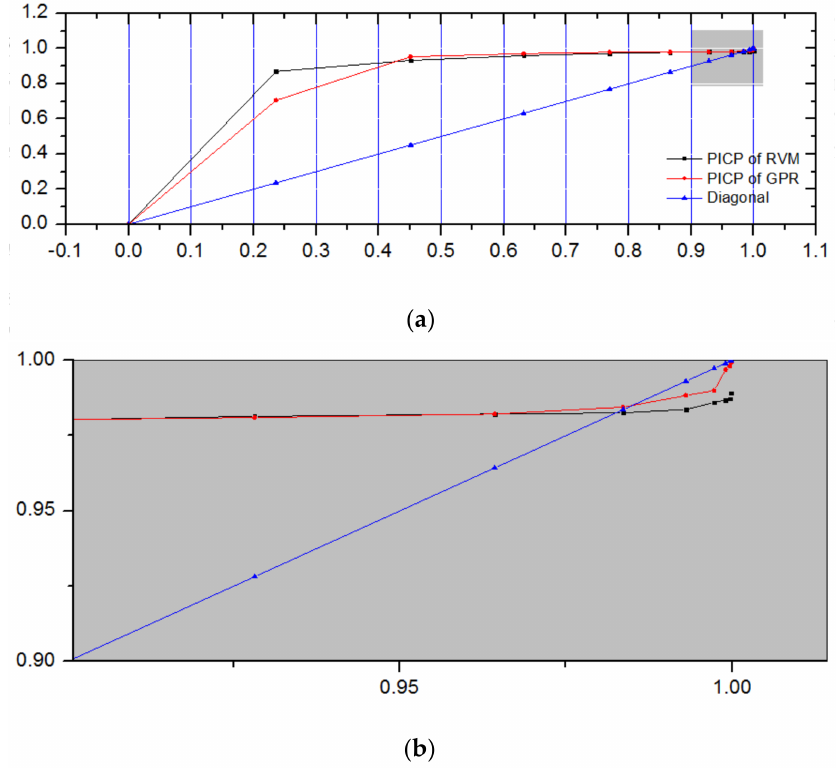
Figure 15. ROC-PI curves of GPR and RVM models for battery telemetry series. ( a ) ROC-PI curves of GPR and RVM models; ( b ) The enlarged figure of ROC-PI